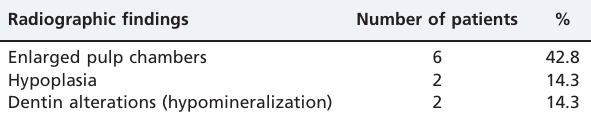
Table 2 – Radiological findings in patients with hypophosphatemic rickets.